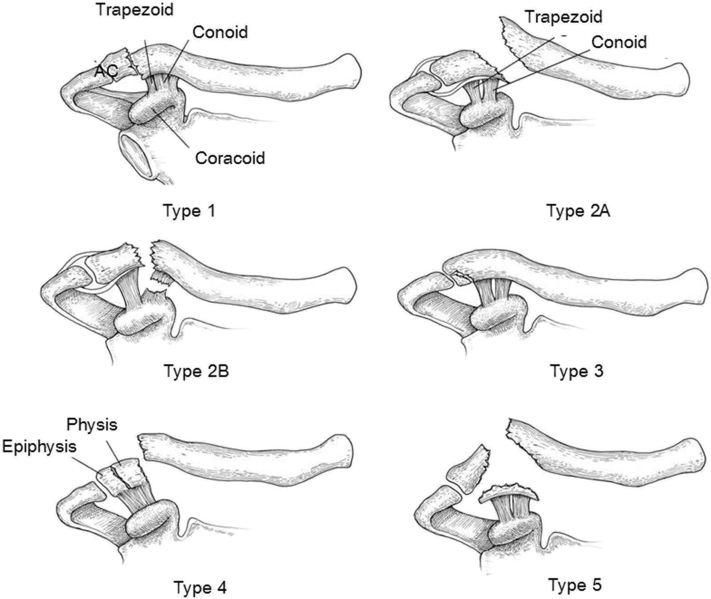
Neer classification. Type 1 is a fracture lateral to the coracoclavicular ligament, in which the conoid and trapezoid remain intact, with minimal displacement. Type 2A is a fracture medial to the coracoclavicular ligament, in which the conoid and trapezoid remain intact, with medial clavicle displacement. Type 2B is a fracture that occurs between or lateral to the coracoclavicular ligaments, in which the conoid is torn and the trapezoid may be intact, with medial clavicle displacement. Type 3 is an intra-articular fracture, in which the conoid and trapezoid remain intact, with minimal displacement. Type 4 is a physeal fracture in an immature skeleton, in which the conoid and trapezoid remain intact, with lateral clavicle displacement. Type 5 is a comminuted fracture, in which the conoid and trapezoid remain intact, with medial clavicle displacement.1AC, acromioclavicular.